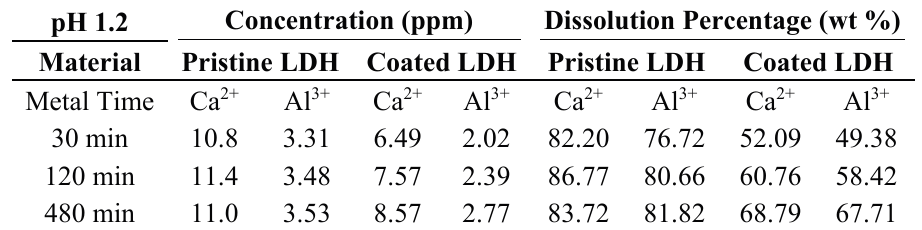
Table 1. Time dependent Ca 2+ dissolution of CaAl-LDH and E-coated CaAl-LDH at pH 1.2.